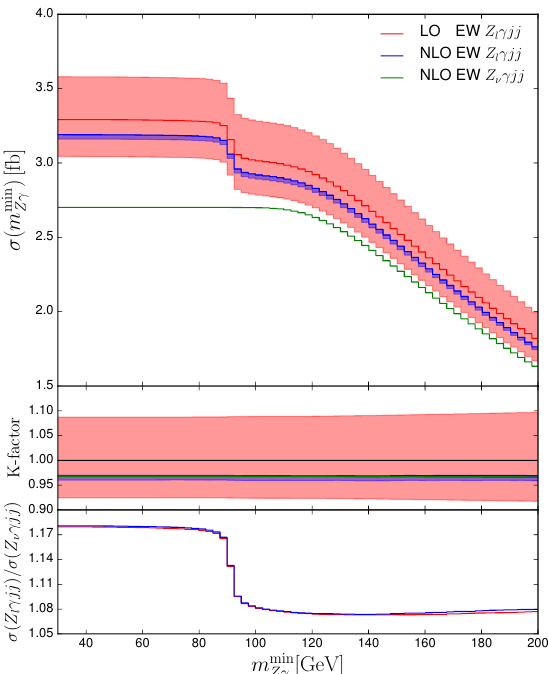
Figure 5 . The dependence of the total cross section on the minimum required invariant mass of the EW system is shown in the upper panel. The other panels show the K-factors and the ratio (cid:27) ( Z ‘ (cid:13)jj ) =(cid:27) ( Z (cid:23) (cid:13)jj